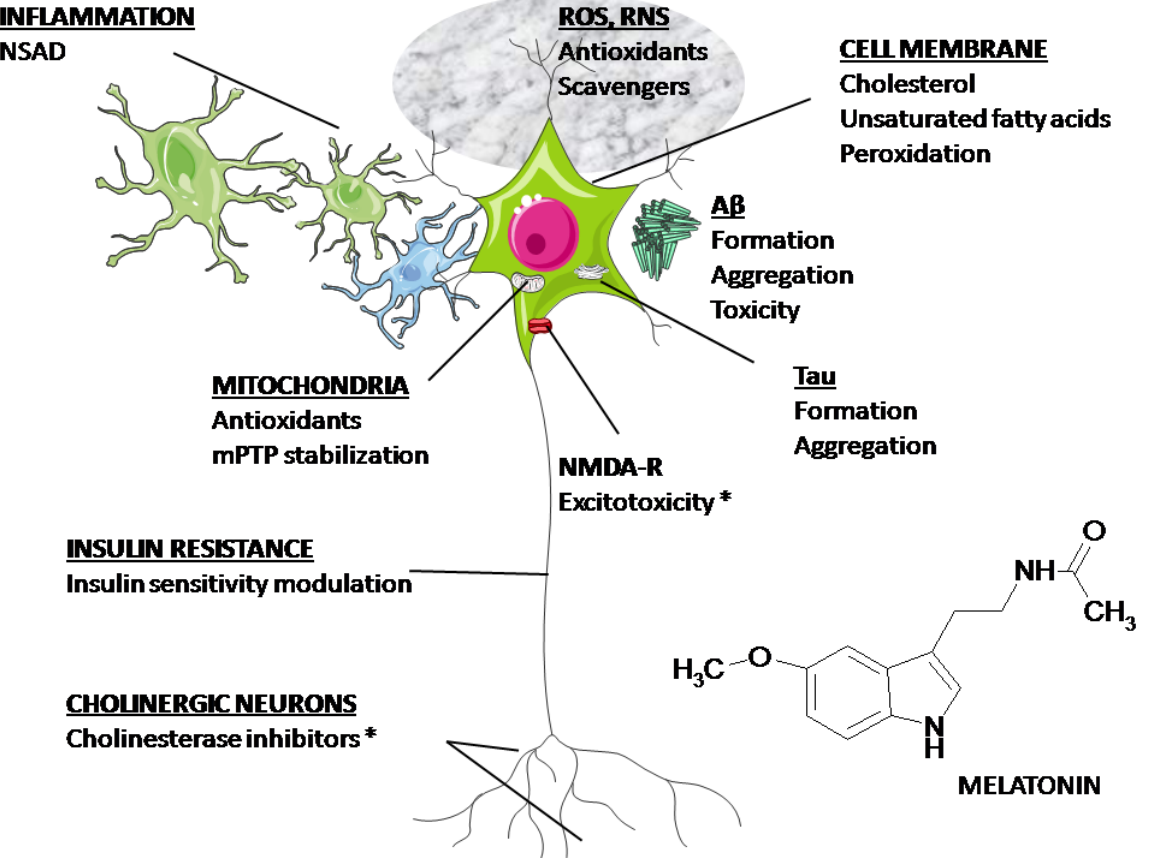
Figure 2. Possible targets for medication in AD. As discussed in the text, melatonin has the potential to affect all the mechanisms depicted in the figure. (*) Approved by the